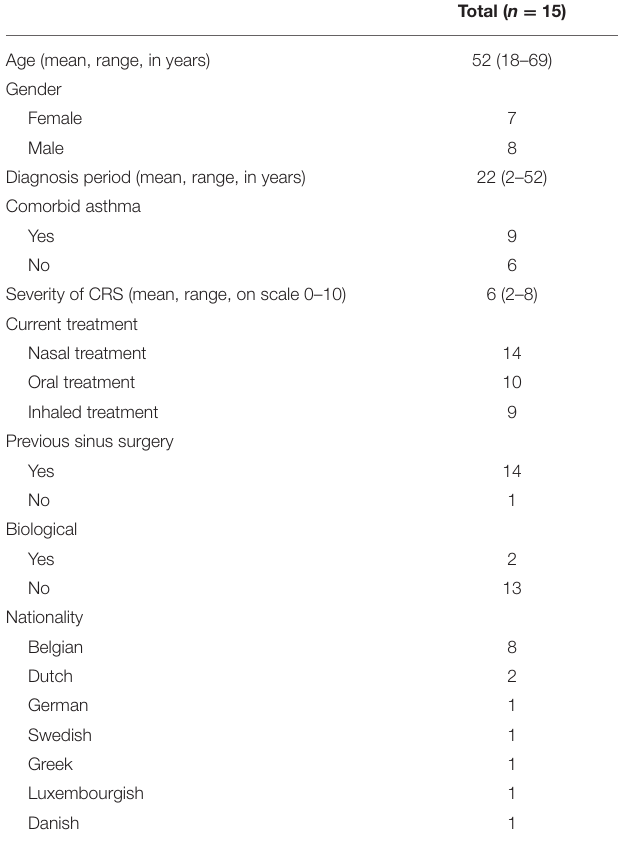
TABLE 1 | Patient